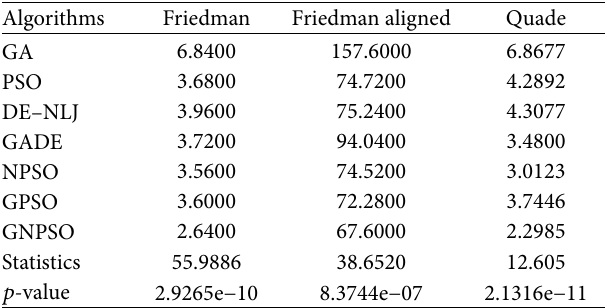
Table 8: Ranks, statistics and related p -values achieved by the Fried- man, Friedman aligned, and Quade tests for control performance of nonlinear wing vibration system obtained by different algorithms.